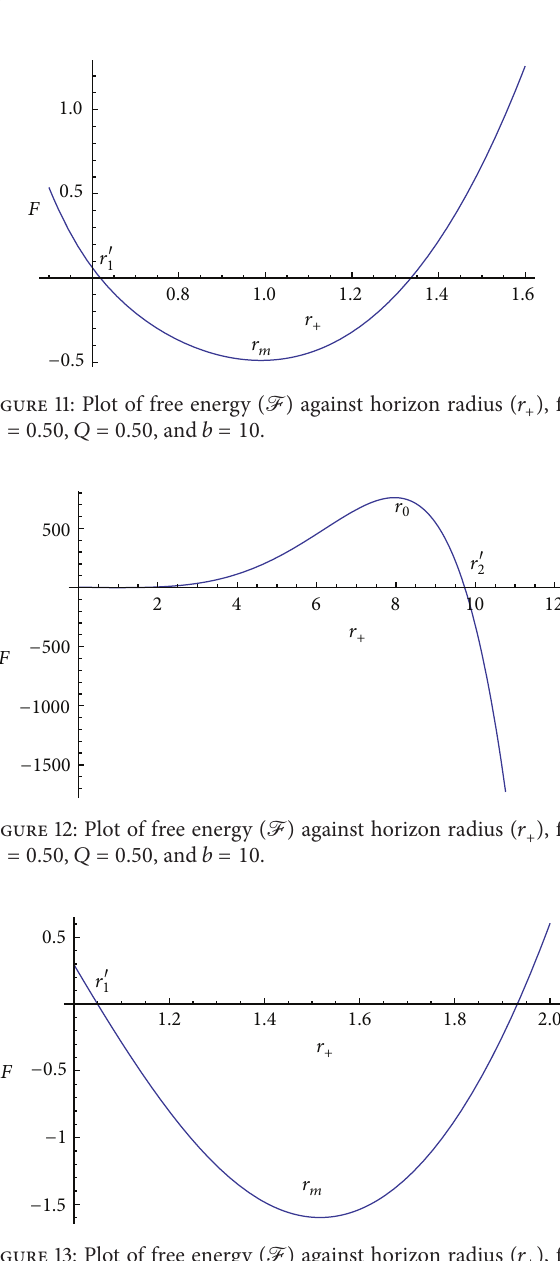
Figure 13: Plot of free energy ( F ) against horizon radius ( 𝑟 + ), for 𝛼 󸀠 = 1.0 , 𝑄 = 5 , and 𝑏 = 0.5 .